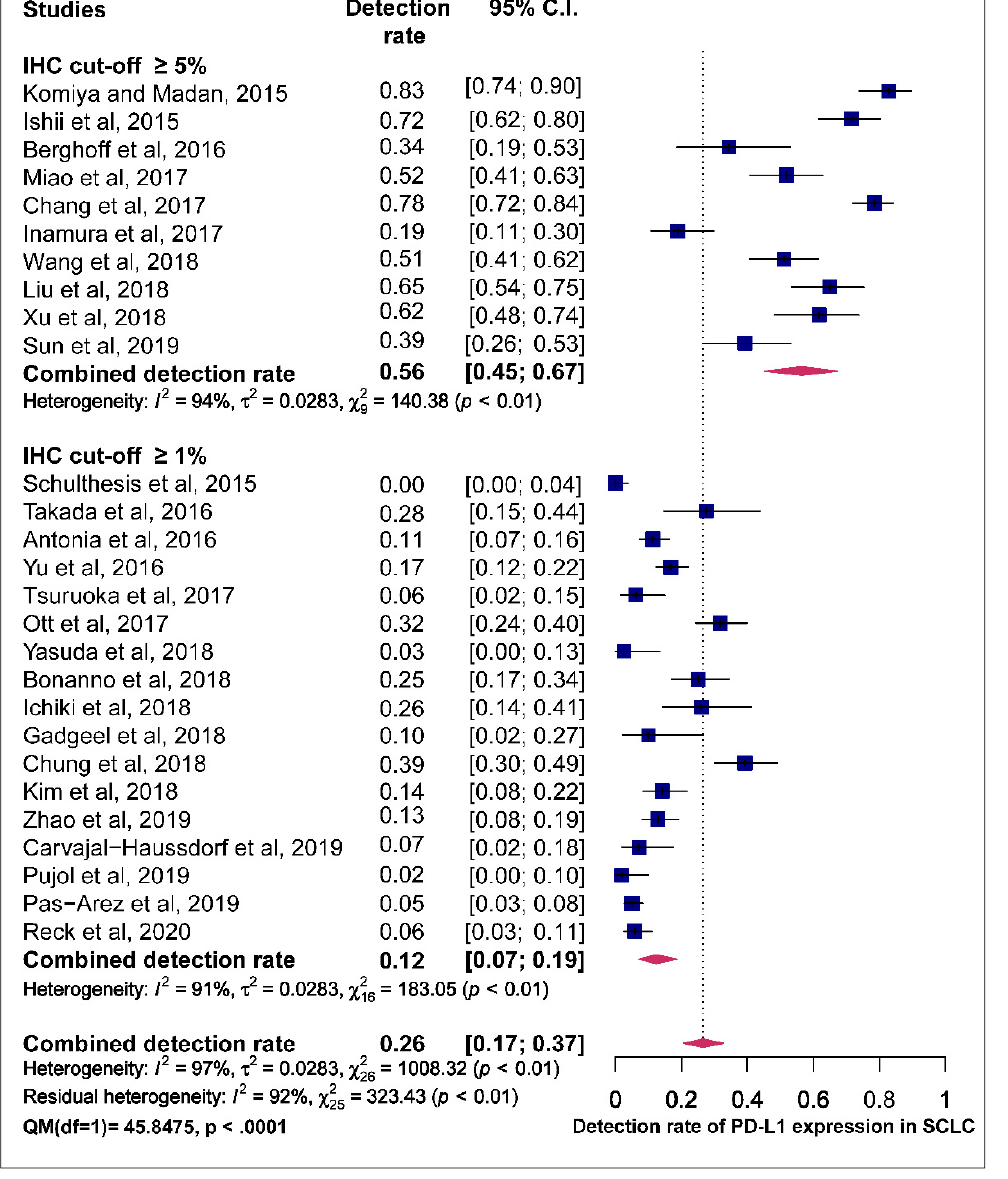
Figure 4. Forest plot of subgroup analysis of the association between immunohistochemistry (IHC) cut-off values and prevalence of PD-L1 expression. The PD-L1 detection rates and 95% CI of each study are represented with a horizontal line and the square area mirrors the effect size of each study A random-effect model was utilised.